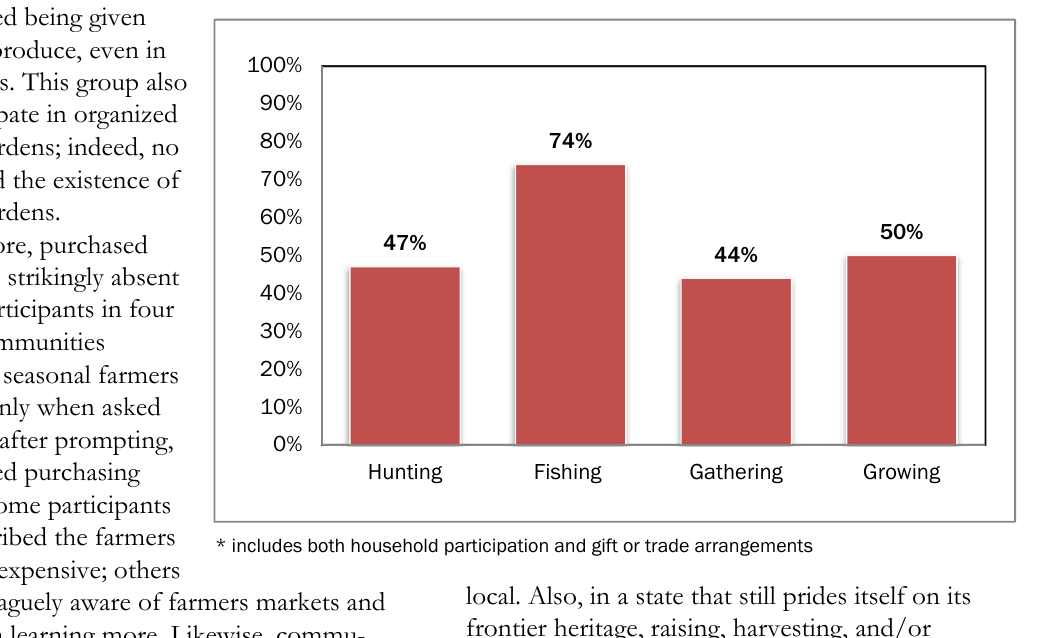
Figure 2. Percent of Sample Engaged in Local Foods